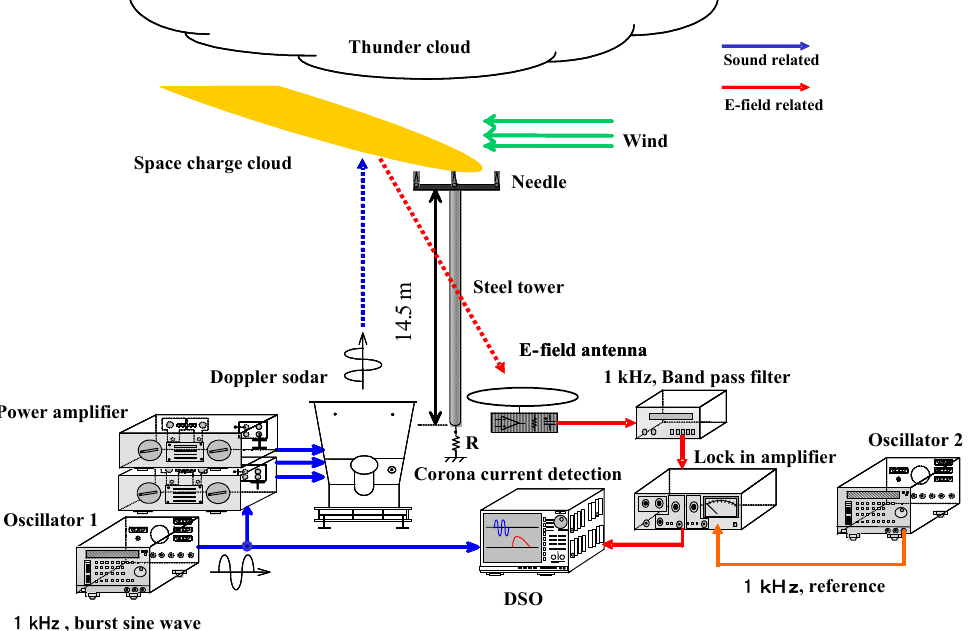
Figure 3 . A schematic illustration of field experiment setup for measuring space charge generated from needles on the top of a steel